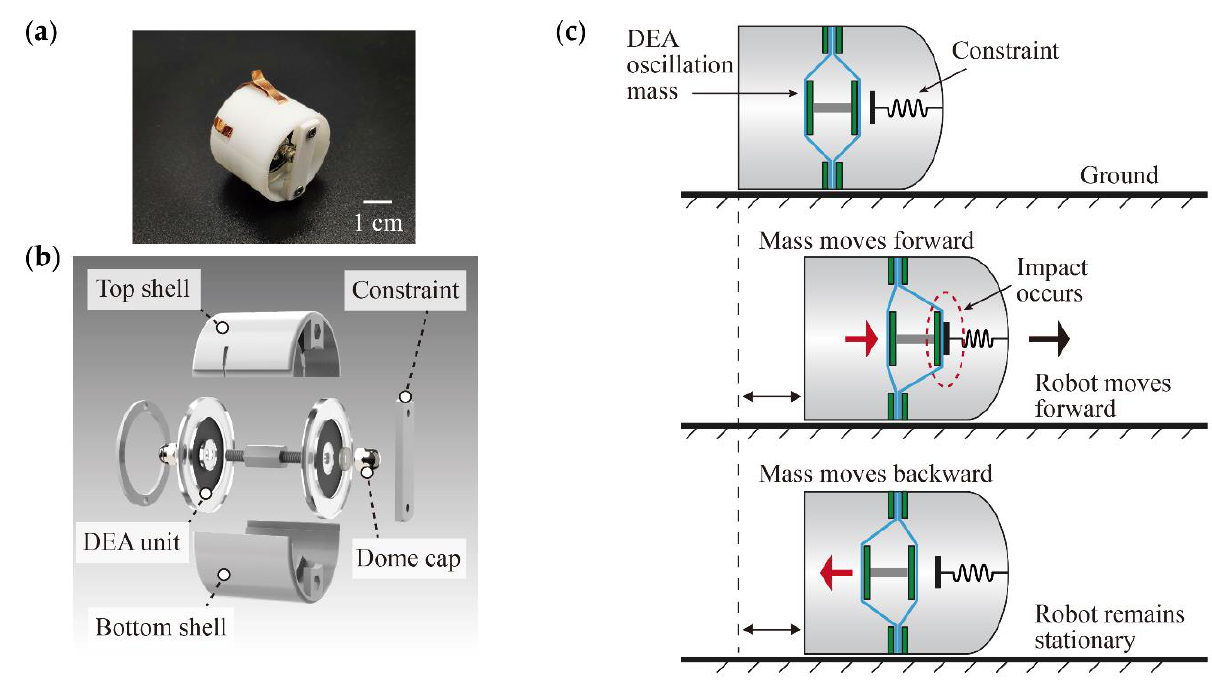
Figure 5. ( a ) Fabricated prototype of the vibro-impact crawling robot; ( b ) Key components of the robot; ( c ) Working principle of the robot.